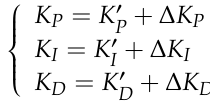
Figure 6. Fuzzy controller with di ff erent Figure 6. fuzzy controller with different dimensions.